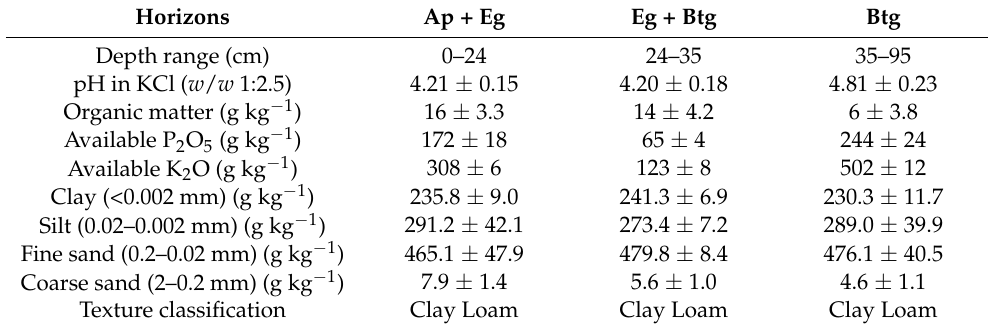
Table 1. Soil profile characteristics of the study site. Values following ± indicate standard deviation.